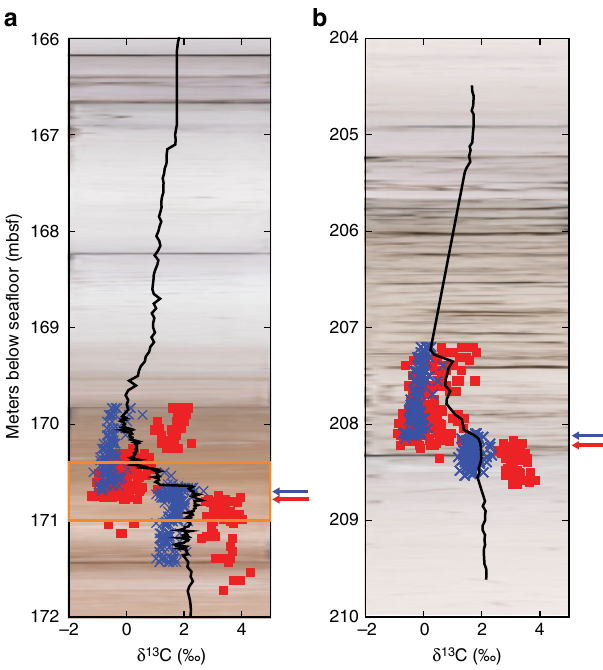
Fig. 1 δ 13 C records from ODP Site 690 and ODP Site 689. Single foraminifer records for mixed-layer ( red ) and thermocline ( blue ) foraminifera across the PETM at a ODP Site 690 (ref. 8 ) and b ODP Site 689 (ref. 17 ). Black lines are bulk carbonate δ 13 C records from ref. 32 . Data are overlain on ODP core photos. Red and blue arrows indicate the onset of the δ 13 C excursion in mixed layer and thermocline dwellers indicated by ref. 17 for each site. Orange box in a highlights the interval expanded in Fig.